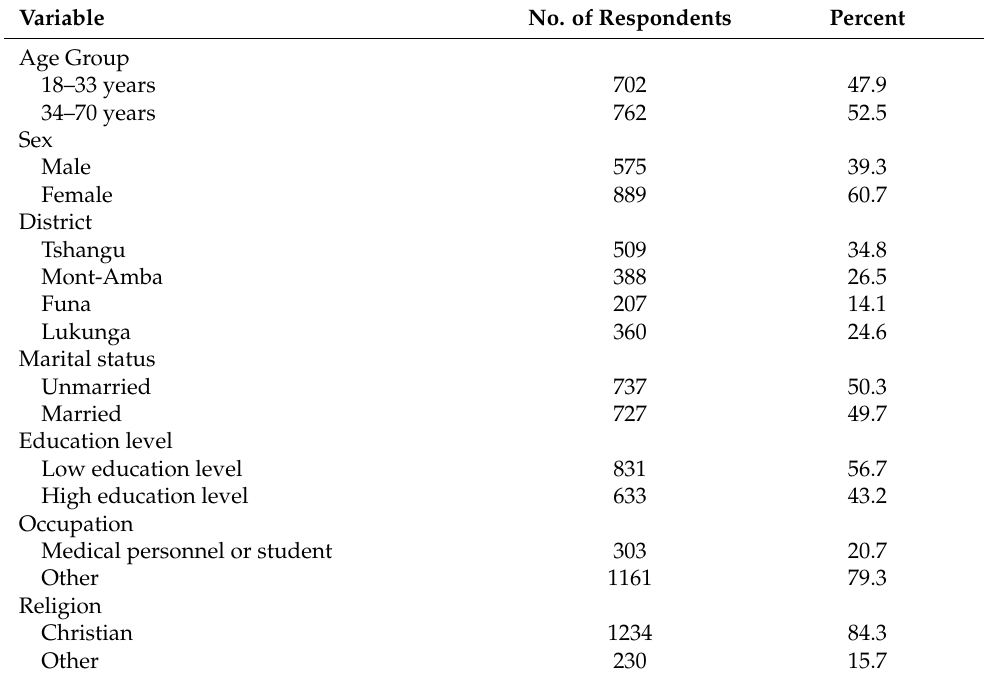
Table 1. Socio-demographic characteristics of the participants.